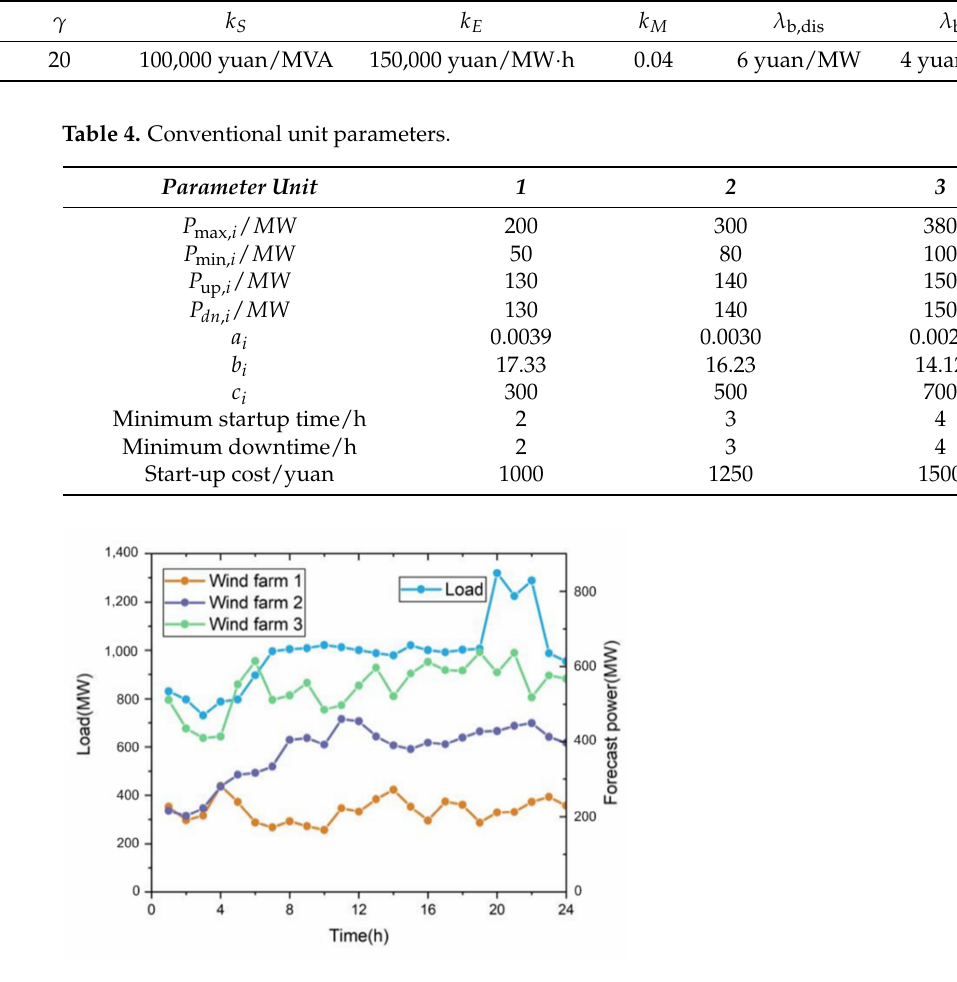
Figure 8. Curve of system load and forecasting power of wind